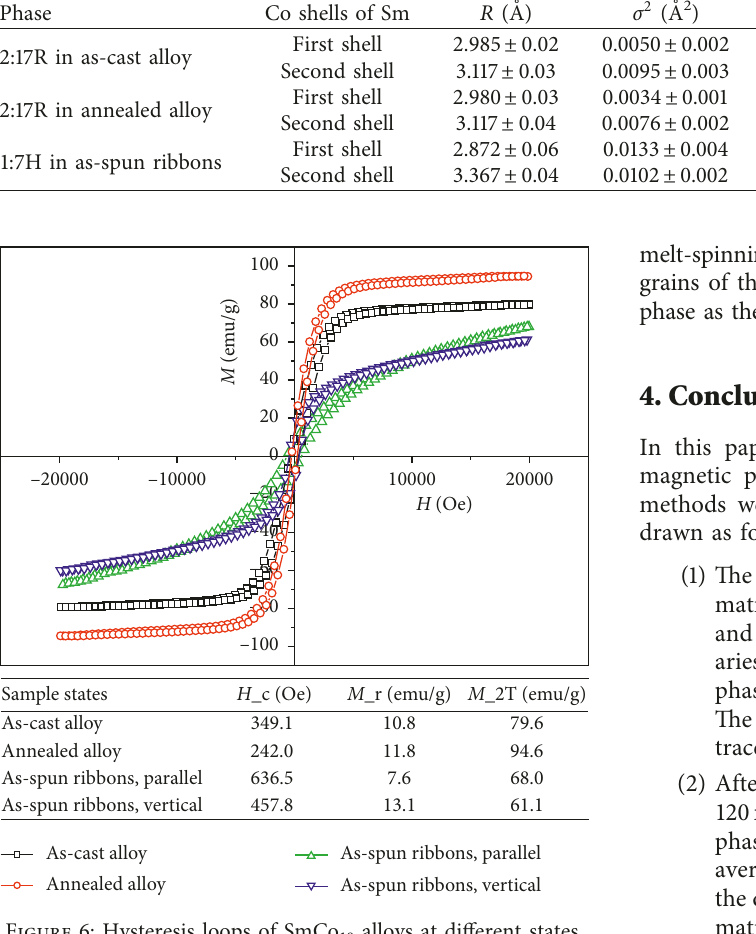
10 alloys at different